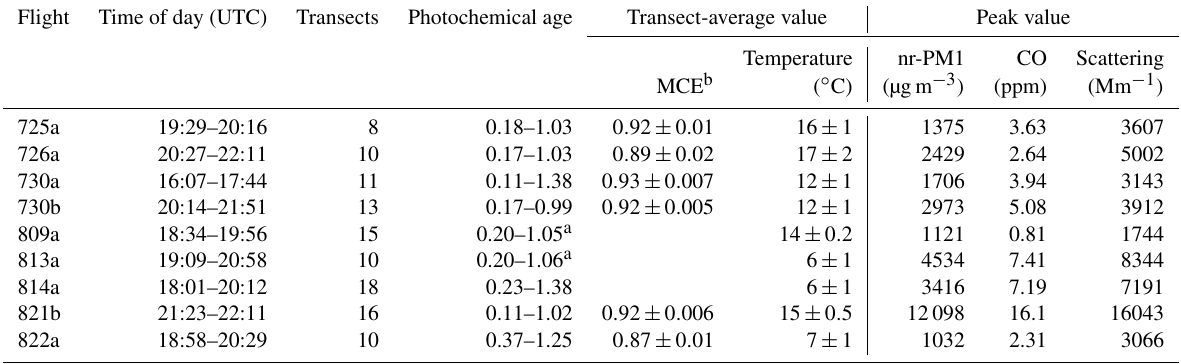
Table 4. Lagrangian flights used for analyzing time evolution of wildfire